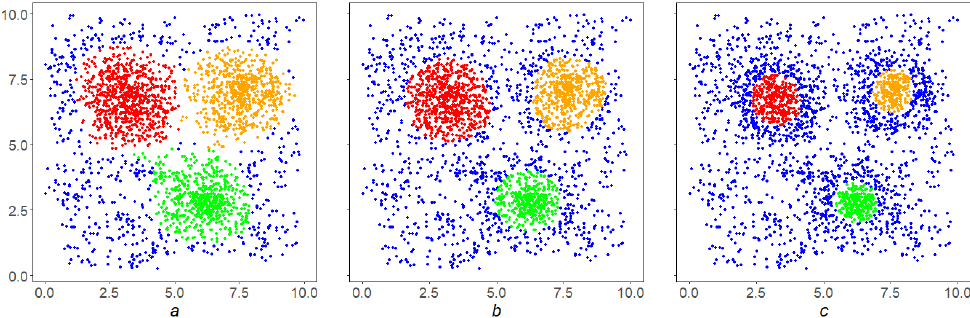
Figure 8. The inverse nature of the dependence of the SDPS algorithm on the parameter p : ( a ) the result of the SDPS algorithm at p = 0; ( b ) the result of work at p = 0.5; and ( c ) the result of work for p = 1 (in all cases q = − 2, β = −